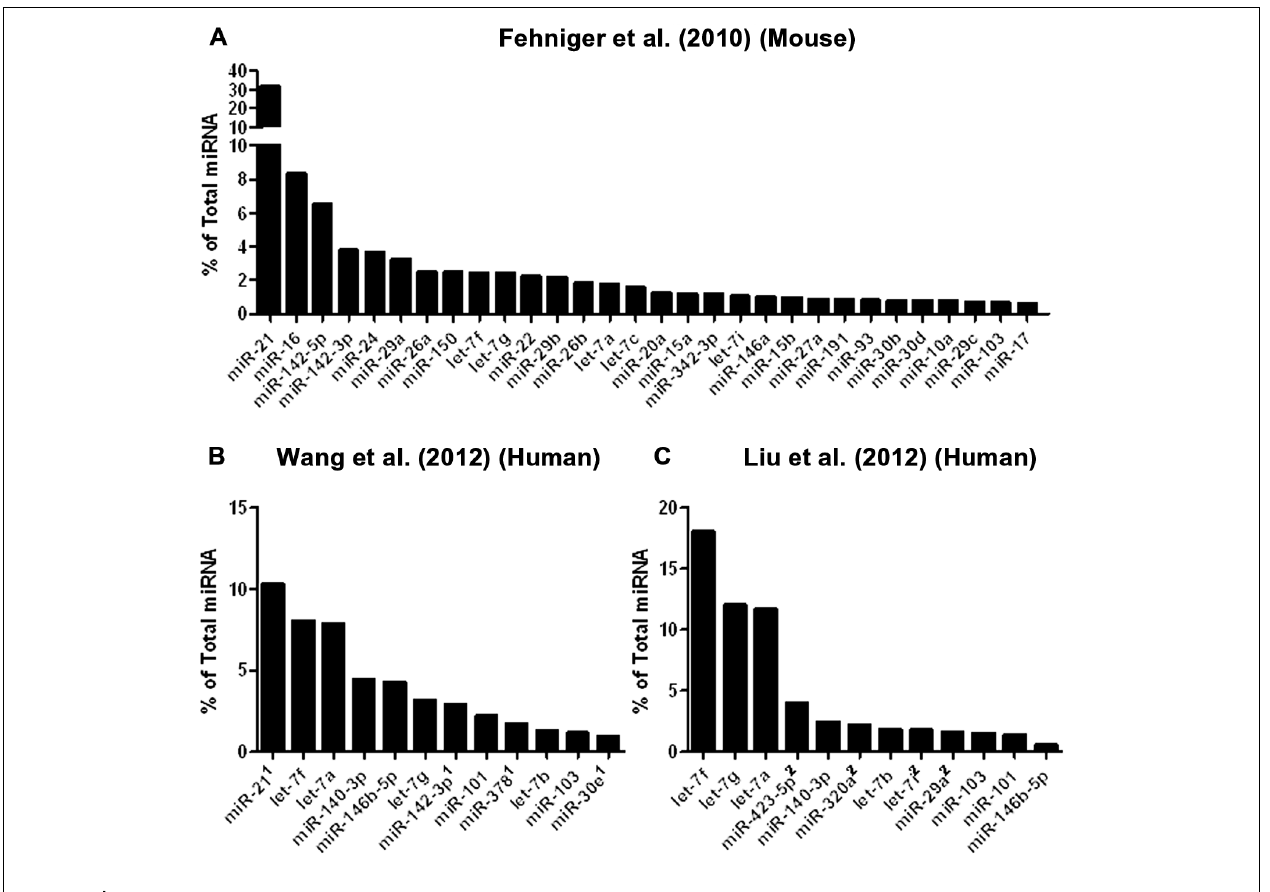
FIGURE 2 | Mouse and human NK cell miRNA expression. (A) The top 30 miRNAs detected by Illumina sequencing in mouse splenic NK cells (Fehniger etal., 2010). (B) Top expressed miRNAs detected and enumerated by small RNA Illumina sequencing of resting human CD56 + CD3 − in theWang etal.’s 2012 study. (C) Top expressed miRNAs detected by small RNA Illumina sequencing in the Liu etal.’s 2012